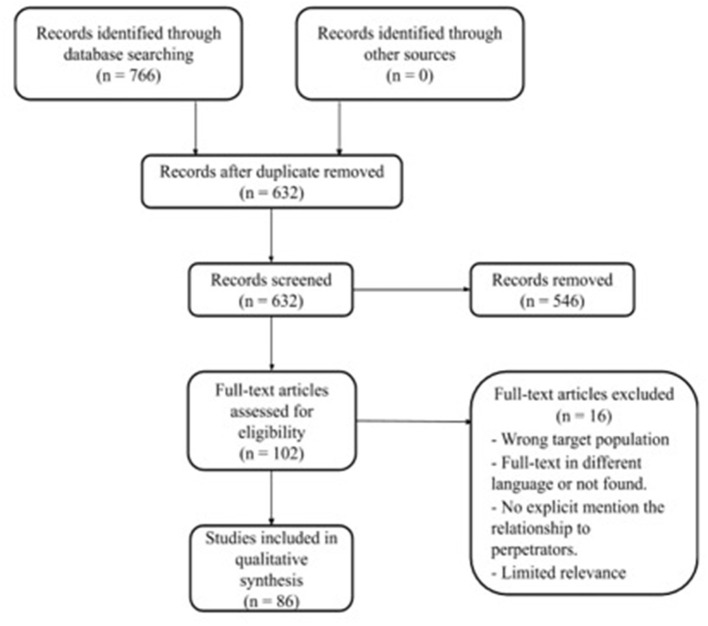
PRISMA flow chart.